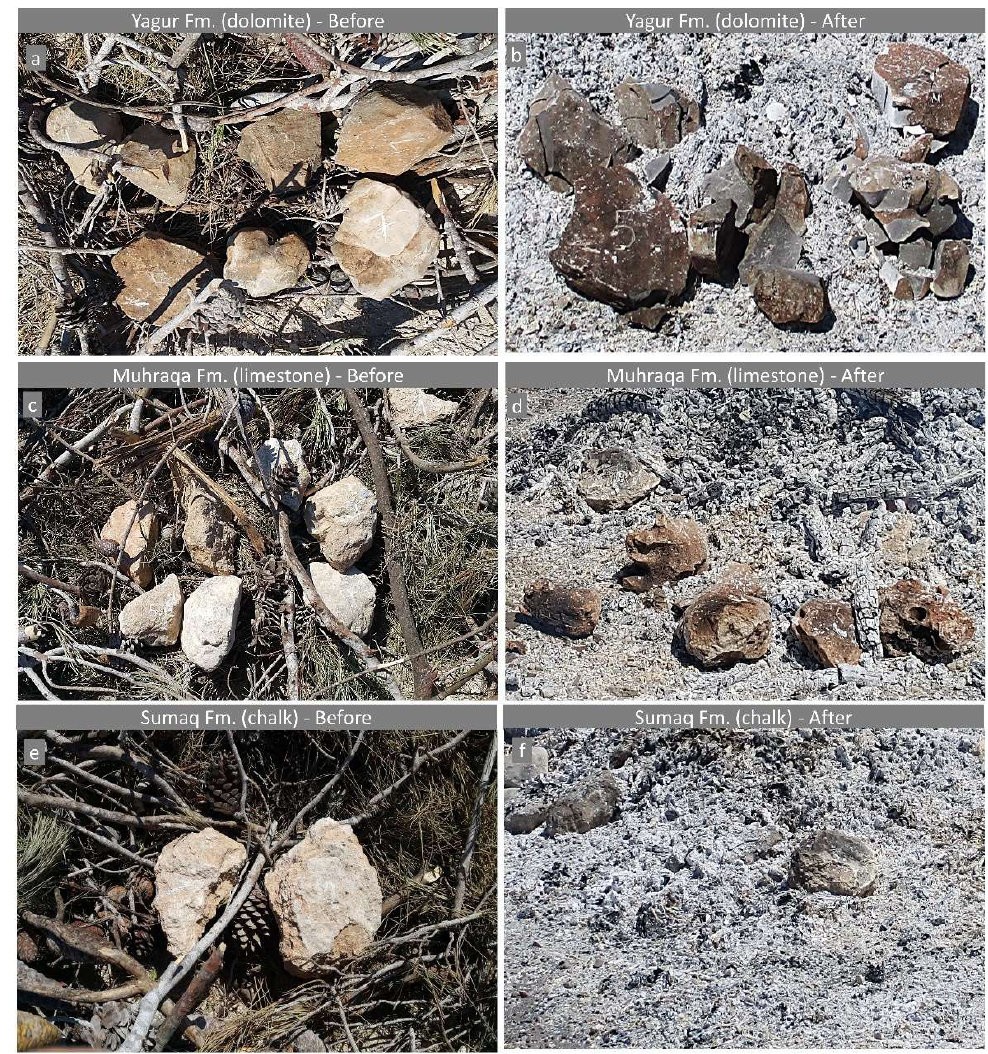
Figure 5. The boulder conditions ”before and after” the open fire (where the temperature reached up to 880 °C); the dolomite boulders completely shattered, while limestone and chalk boulders cracked but only partially broke down.